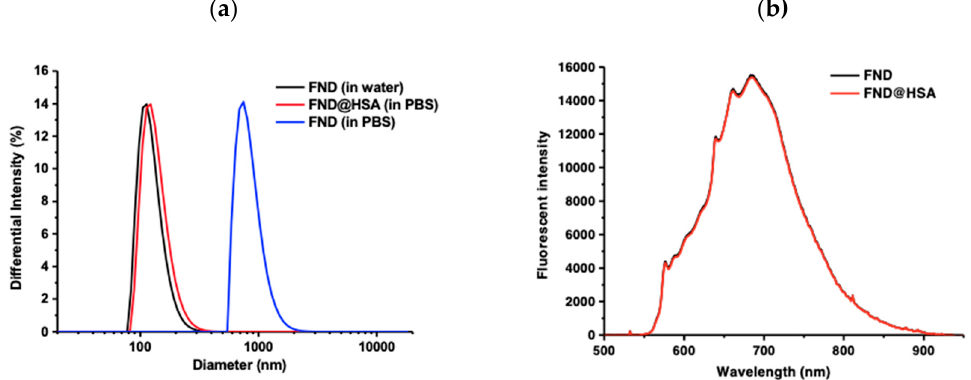
Figure 1. ( a ) Dynamic light scattering measurements of the size distributions of FNDs with or without HSA conjugation in distilled deionized water and PBS. ( b ) Fluorescence spectra of FNDs before and after conjugation with HSA (FND@HSA). The emission spectrum was acquired by laser excitation at 532 nm.